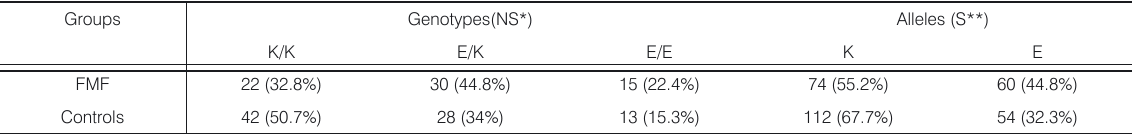
Table 2. ICAM-1 E/K 469 genotype distribution and allele frequencies of FMF patients and healthy Groups